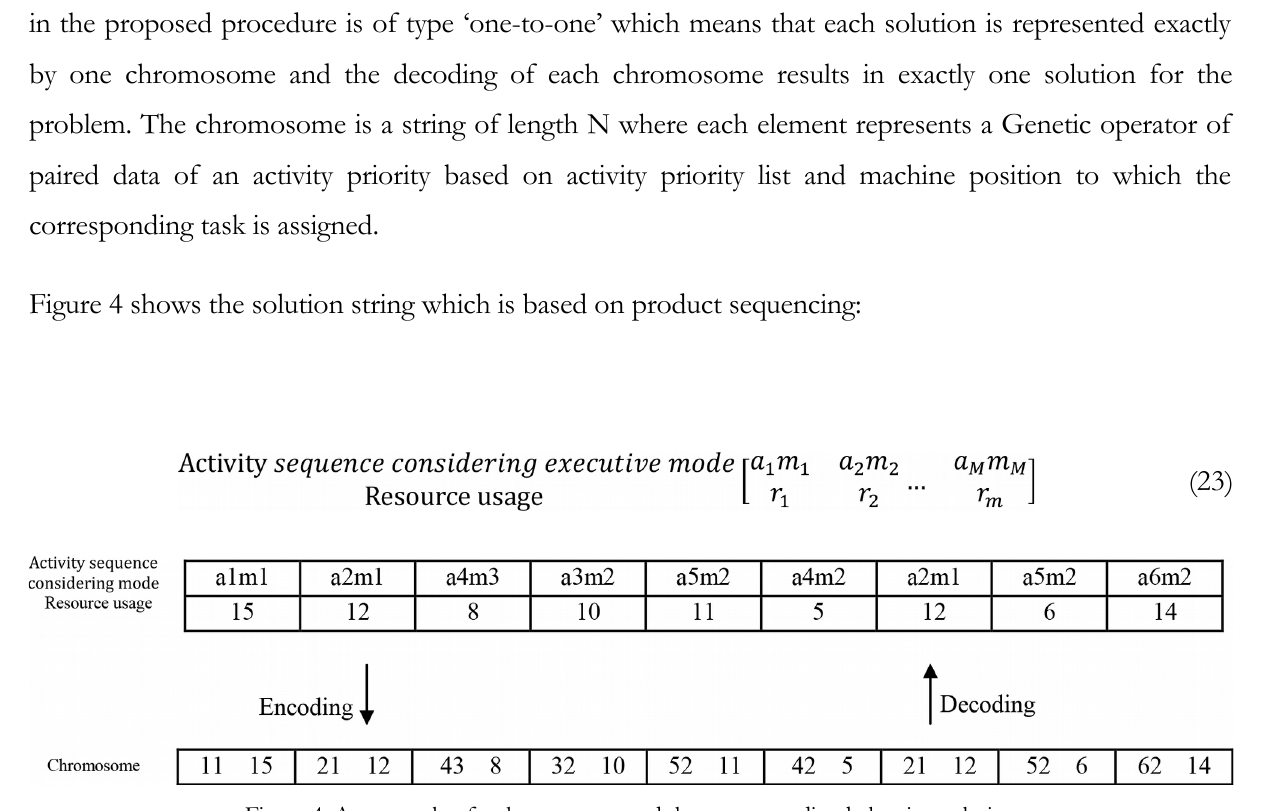
Figure 4. An example of a chromosome and the corresponding balancing